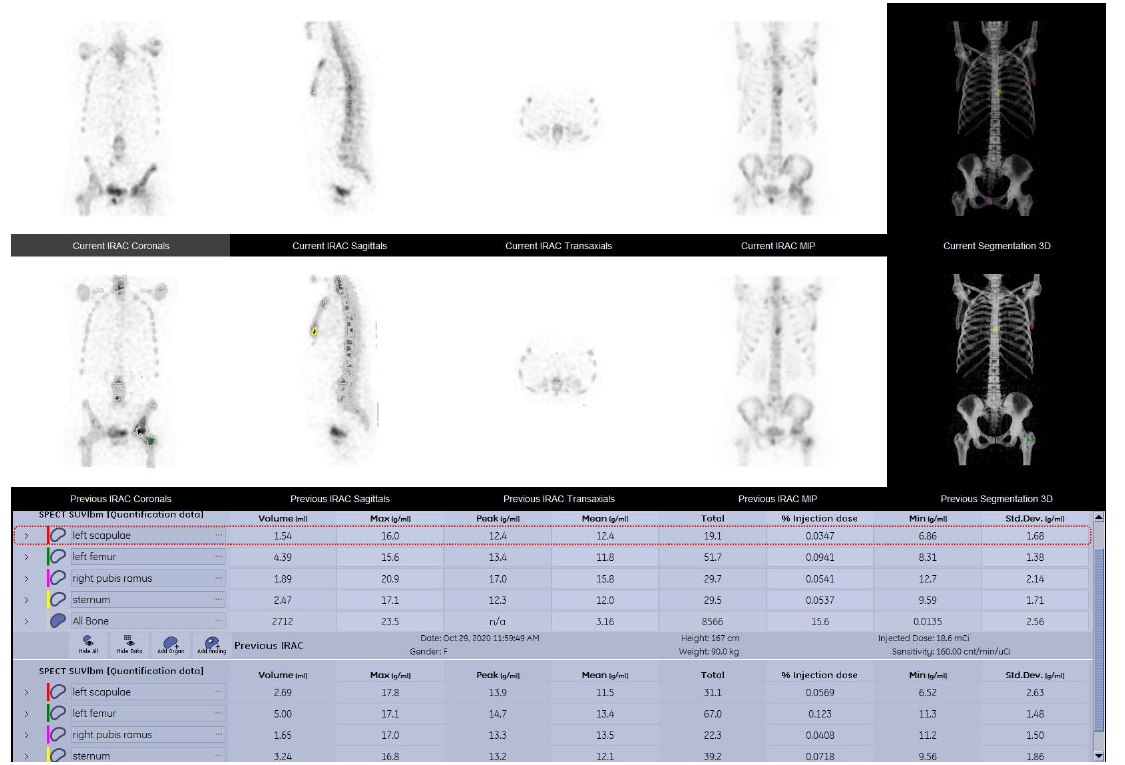
Figure 3. SPECT-CT data quantitative analysis results displayed in comparison between the baseline and the follow up study of a 52-year-old female breast cancer patient with grade two lobular inva- sive breast carcinoma, presenting multiple metastatic lesions, following chemotherapy and osteo- clast inhibitor.